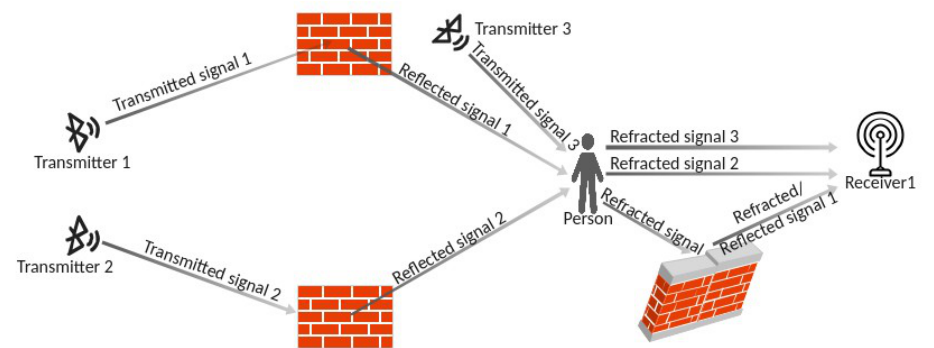
Figure 2. Multipath (Non-LoS) PHS. Note that multiple signals traverse the same obtruding human body from different angles and with different time (phase) shifts, thus transporting spatially and temporally diverse